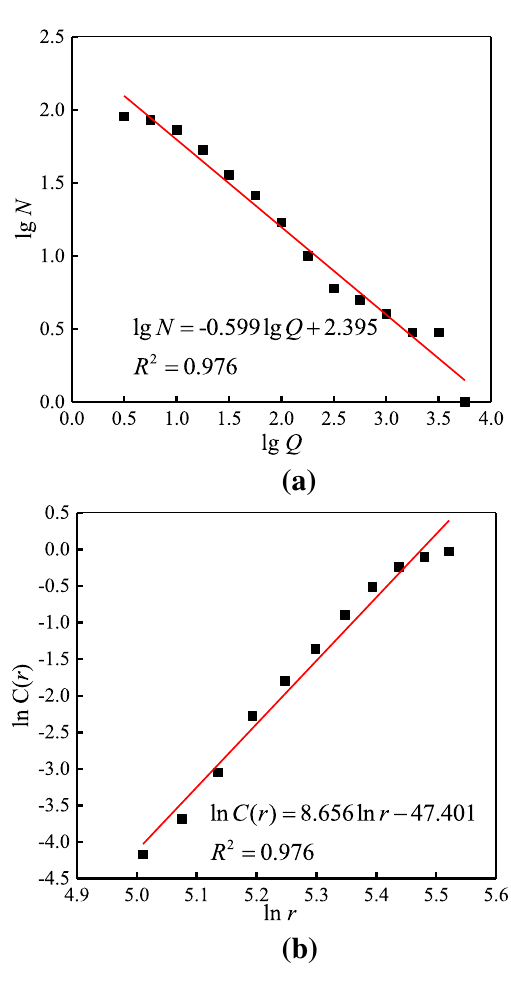
Fig. 6 Linear fitting of AE b -value and correlation dimension: a AE b -values, b AE correlation